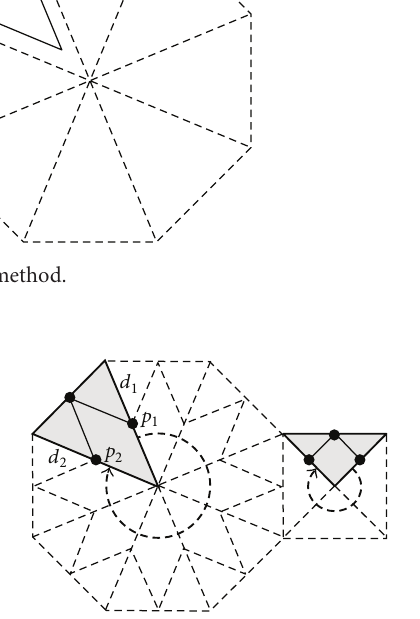
Figure 15: Point on segment control diagram (Type C).